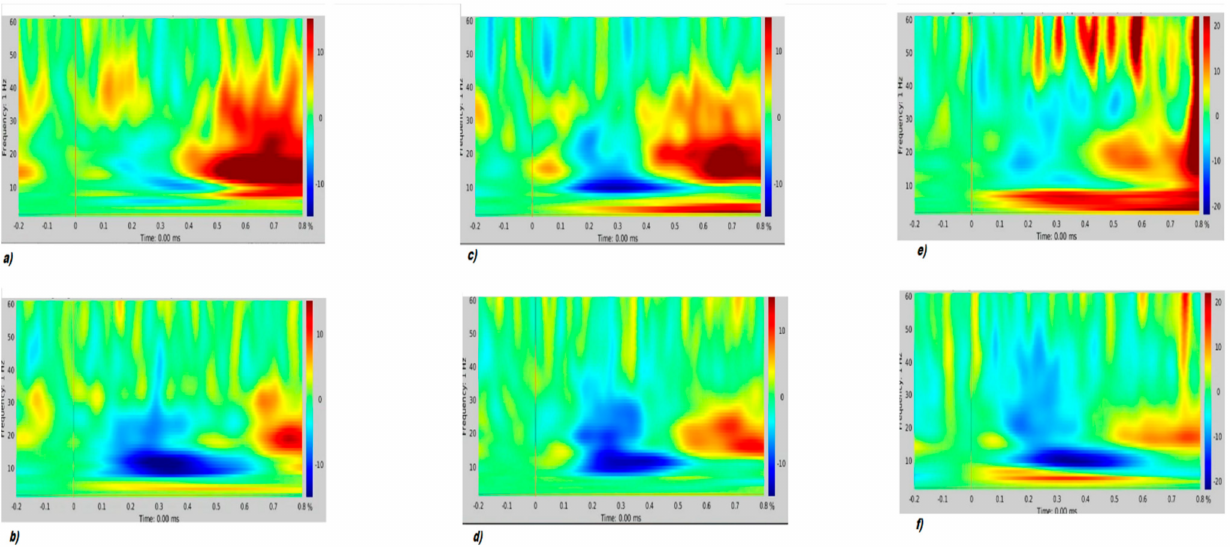
Figure 3. Standard trial. Representative parietal midline gradiometer ( a , b ), magnetometer ( c , d ) and electroencephalography (EEG) derivation ( e , f ) for HCs (top) and pwMS (bottom).